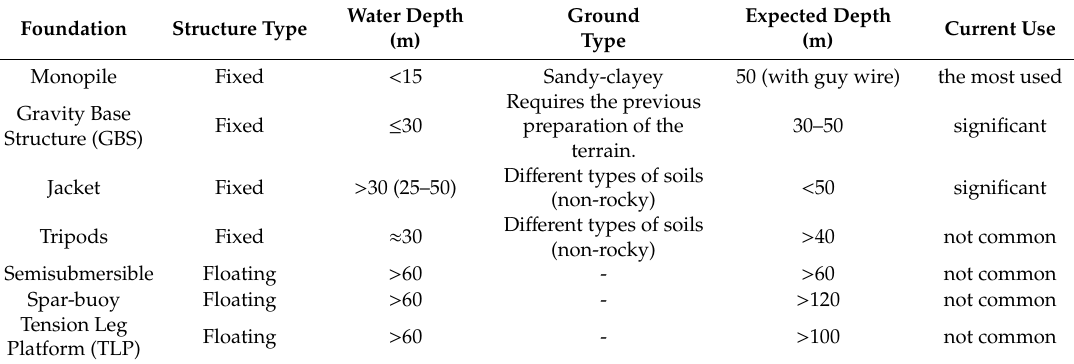
Table 1. Summary of foundation types, depths, and use